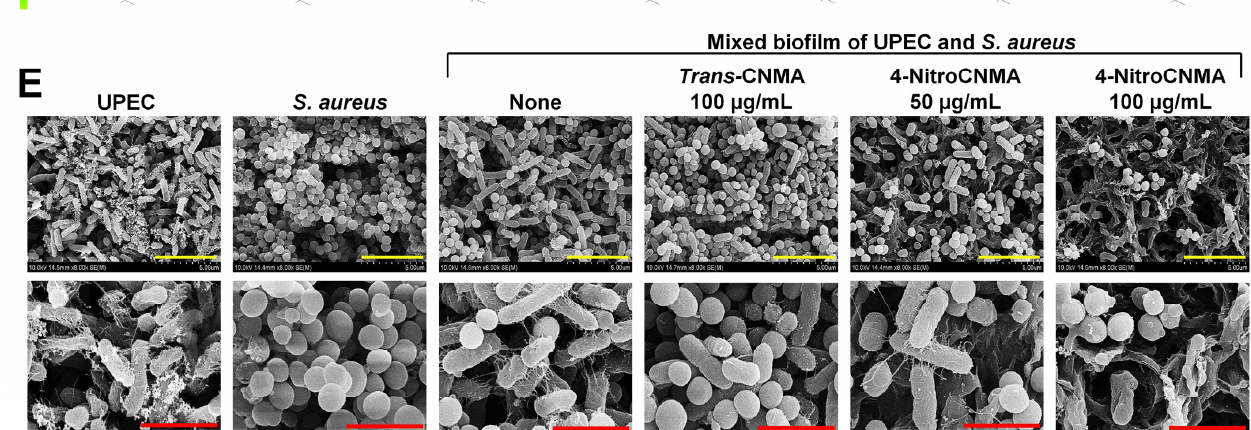
Figure 6. Antibiofilm activities of trans -CNMA and 4-nitroCNMA against mixed UPEC/ S. aureus biofilms. Optimization of culture medium at 37 and 30 °C ( A ). Antibiofilm effects of trans -CNMA ( B ) and 4-nitroCNMA ( C ) on UPEC/ S. aureus biofilms for 24 h. * p < 0.05 vs. nontreated controls (None). The 2D and 3D images of UPEC/ S. aureus biofilms ( D ) after culturing in the presence of trans -CNMA or 4-nitroCNMA for 24 h. The black scale bar represents 10 µm. SEM images ( E ) of UPEC/ S. aureus biofilms formed in the presence or absence of trans -CNMA or 4-nitroCNMA. Yellow and red scale bars indicate 5 and 2 µm, respectively.